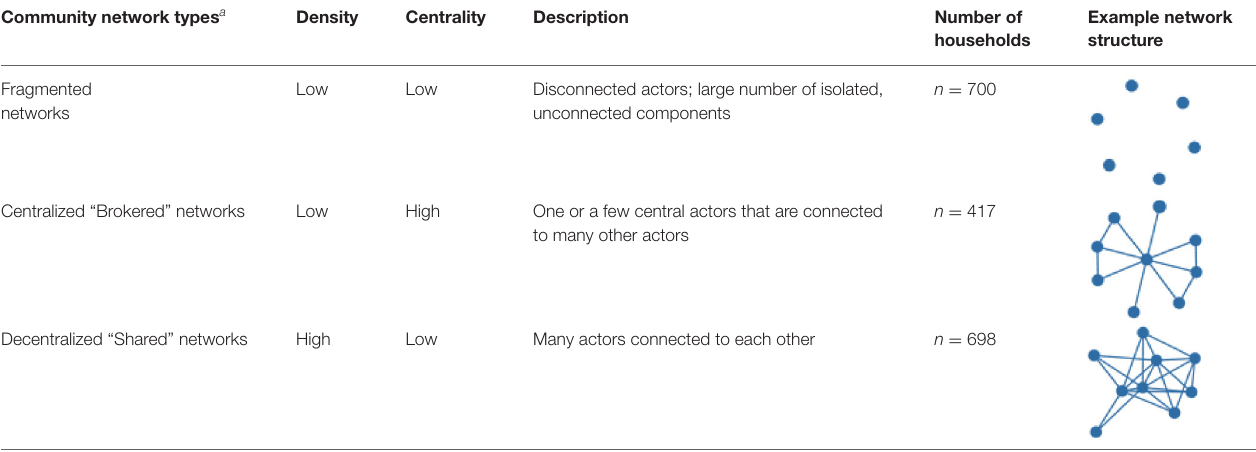
TABLE 1 | Community social network types and brief